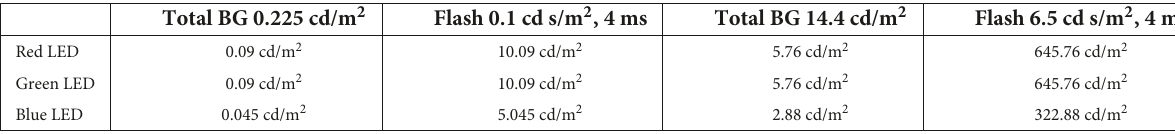
TABLE 1 Control flash electroretinogram (ERG) stimuli